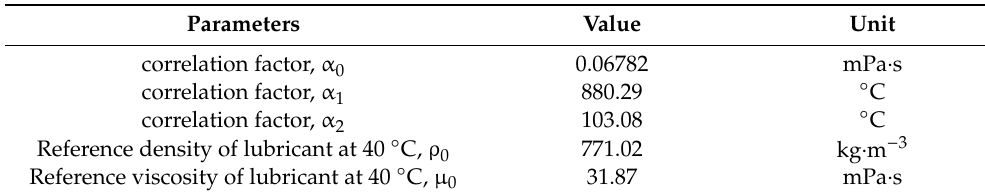
Table 2. Parameters of